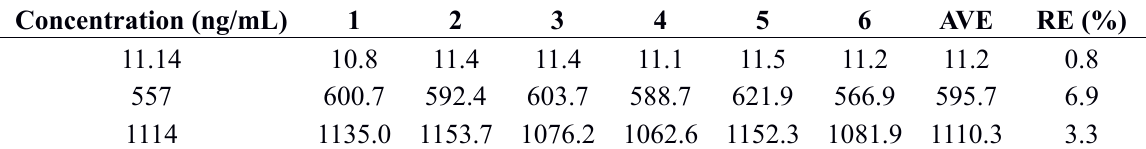
Table 8. Post-preparative stabilities at room temperature for 24 h ( n = 6).